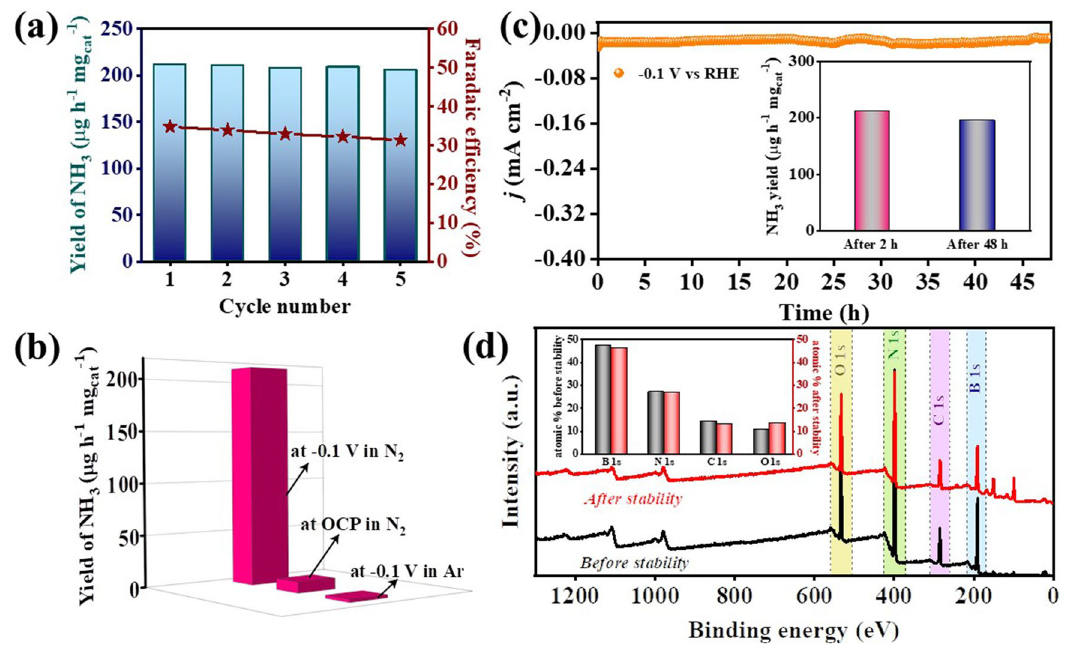
Fig. 7 a Yield of NH 3 and FE of ammonia production on BNCO (1000) catalyst after cycling experiments, holding − 0.1 V vs RHE for 2 h for each cycle. b Comparative bar plot of yield of NH 3 in N 2 and Ar, at − 0.1 V and in N 2 at OCP for BNCO (1000) catalyst (2 h chronoamperometric test). c Stability of BNCO (1000) catalyst for 48 h at − 0.1 V, inset showing NH 3 yield after 2 h and 48 h. d Before and after stability comparison of XPS full survey spectra of BNCO (1000) catalyst, inset shows the bar diagram of the atomic % of B, N, C, and O for fresh and after-stability